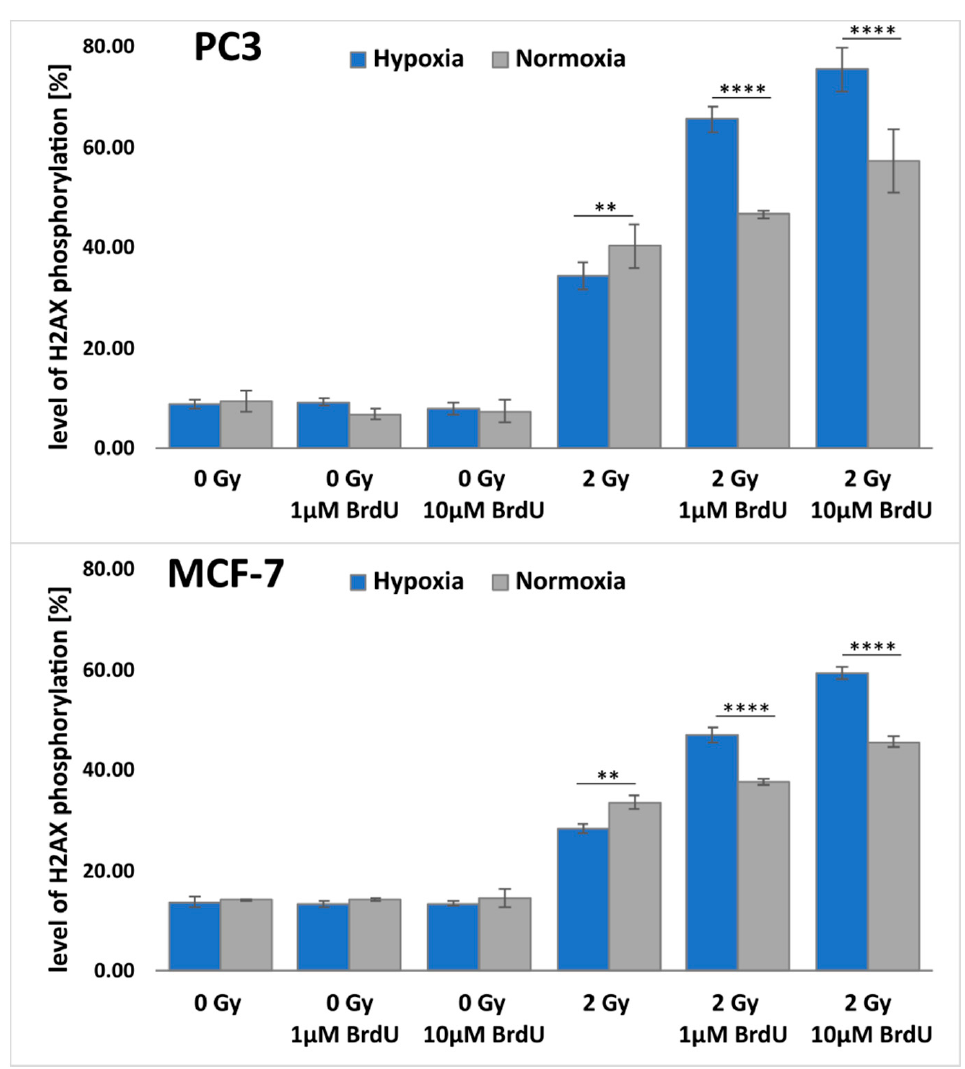
Figure 4. Flow cytometric analysis of H2A.X phosphorylation. γ H2A.X was measured 1 h after irradiation. Results are shown as mean ± standard deviation of at least three independent experi- ments. The statistical significance was determined by one-way ANOVA followed by Tukey’s multiple comparison test: **** p < 0.0001, ** p < 0.01.